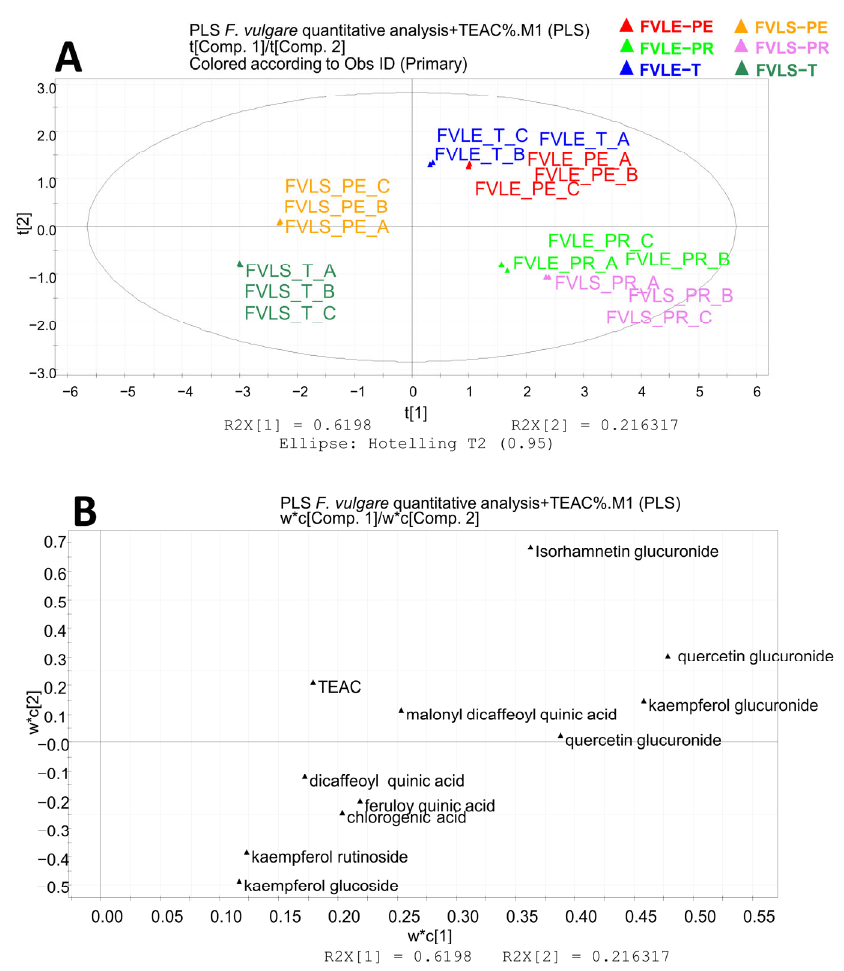
Figure 5. Partial least square analysis: quantitative results related to the antioxidant activity (TEAC) of the ethanolic extracts of F. vulgare waste. ( A ) Score scatter plot; ( B ) loading plot. FVLE-T, Foeniculum vulgare leaf Tiziano variety; FVLE-PE, Foeniculum vulgare leaf Pegaso variety; FVLE-PR, Foeniculum vulgare leaf Preludio variety.